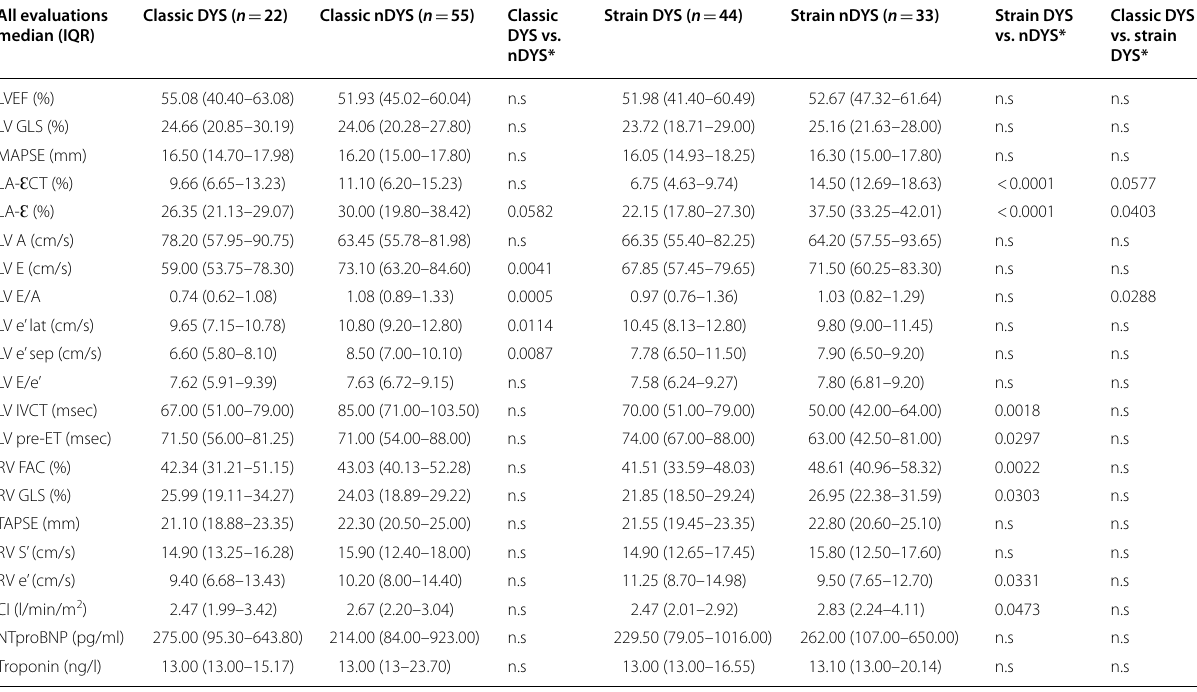
Table 1 Comparison of echocardiographic, hemodynamic parameters and cardiac biomarkers between left ventricle diastolic dysfunction by classic criteria vs. left atrium